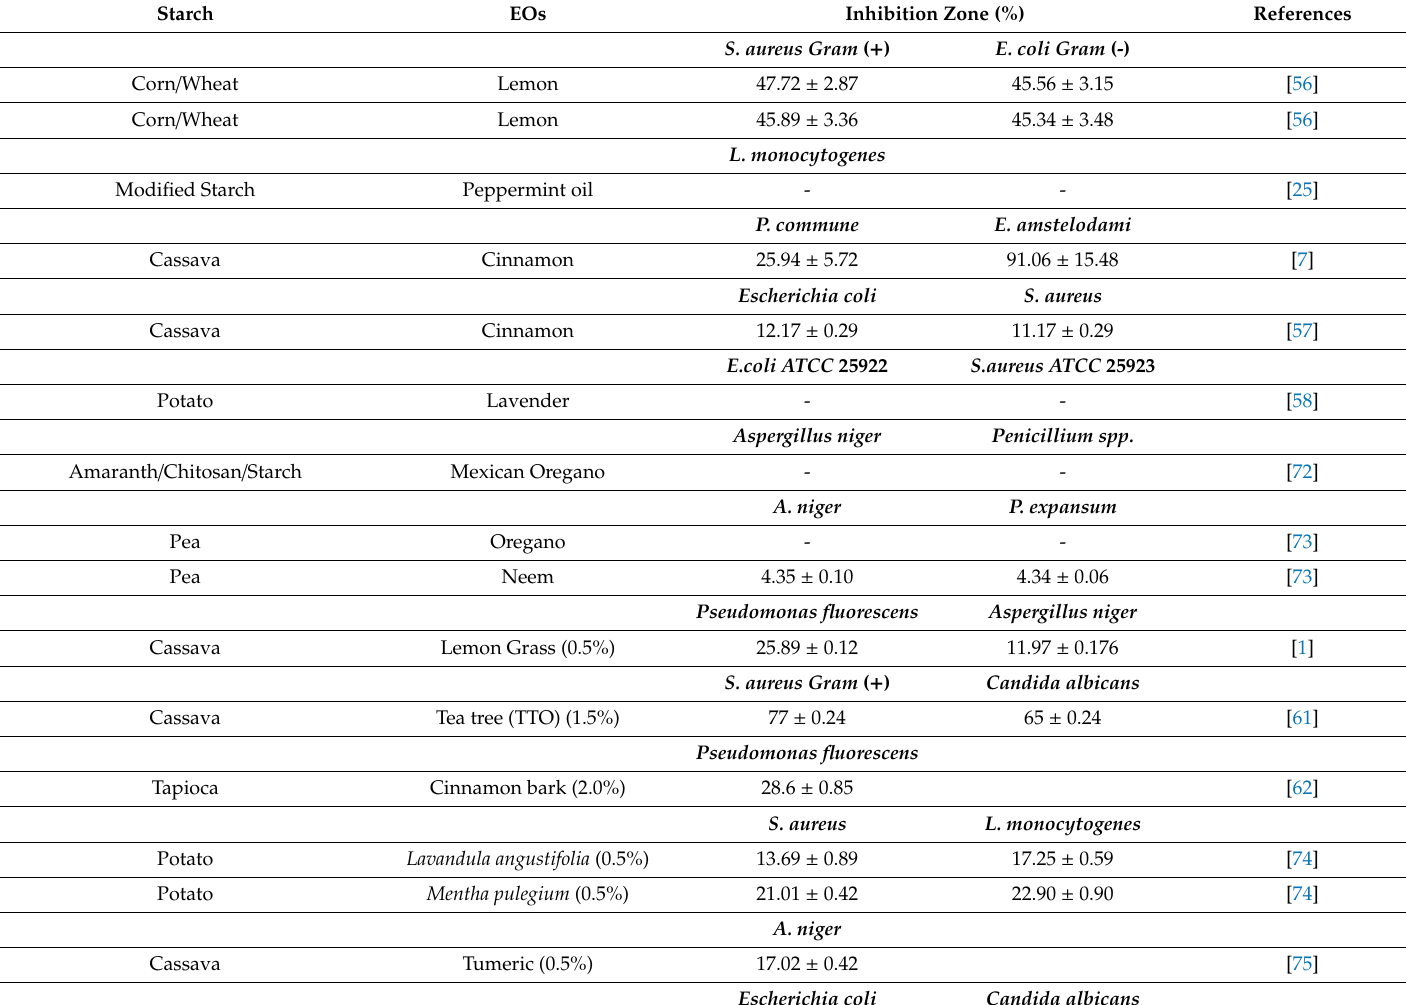
Table 2. Starch-based polymer film incorporated with antimicrobial plant EOs for food packaging